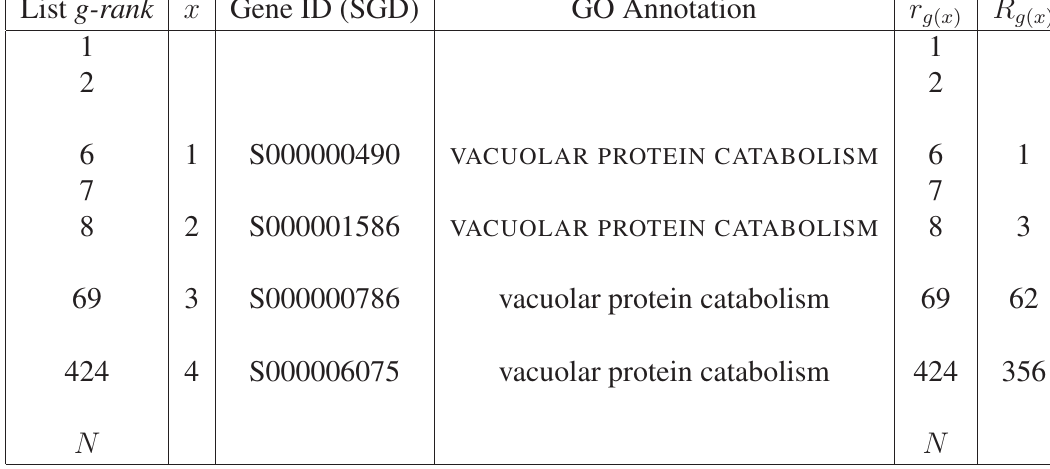
CGGA tested for H the (4*5)/2=10 FEG subsets computing their pc-value and comparing it to 0 the p-value . For example, the pc-value corresponding to the subset { S000000490, S000001586 } of rank 6 and 8 in g-rank is 2 . 63 E − 05 (cf. Table 2). This pc-value being lower than p-value